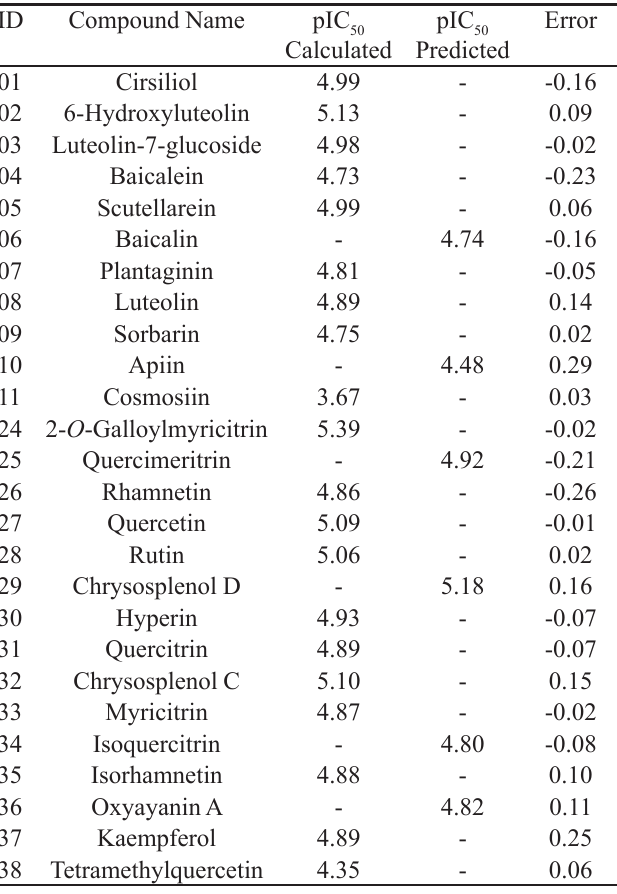
TABLE IV - Calculated, predicted and error values for antioxidant activity